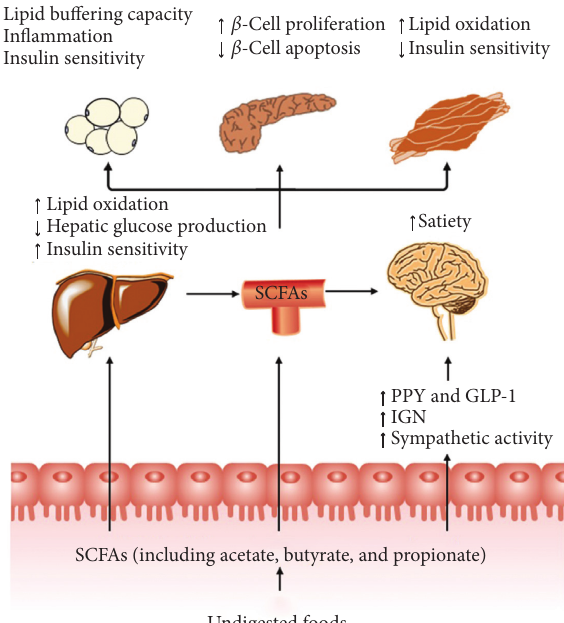
Figure 2: Impact of gut-derived SCFAs in T2DM. SCFAs (acetate, butyrate, and propionate) are produced from the fermentation of indigestible foods in the distal intestine by gut microbiota. In the distal gut, acetate, propionate, and butyrate stimulate the secretion of the “satiety” hormones GLP-1 and PYY in enteroendocrine-L cells, which leads to metabolic benefits upon satiety and glucose homeostasis. Furthermore, butyrate and propionate induce IGN and sympathetic activity, thereby beneficially leading to control of body weight and glucose homeostasis. Very little propionate and butyrate and a high concentration of acetate reach the circulation. They can also affect the metabolism and function of peripheral tissues directly (e.g., liver, adipose tissue, and muscle). Furthermore, circulating levels of acetate and propionate might cross the BBB and regulate satiety via CNS-related mechanisms. BBB, blood-brain barrier; CNS, central nervous system; GLP-1, glucagon-like peptide-1; GSIS, glucose-stimulated insulin secretion; IGN, intestinal gluconeogenesis; PYY, peptide YY; SCFAs, short-chain fatty acids; T2DM, type 2 diabetes